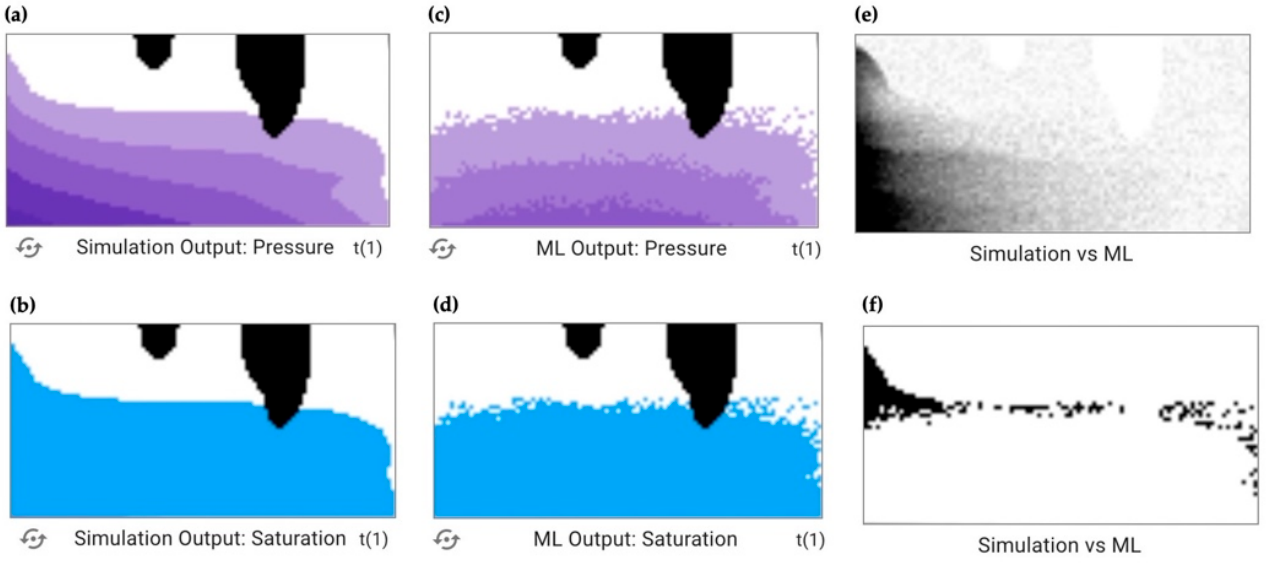
Figure 4. Display of a Sandtank-ML application run, showing ( a ) the “goal” simulation output for pressure, ( b ) the “goal” simulation output for saturation, ( c ) the ML pressure output using a dry dataset, ( d ) the ML saturation output using a dry dataset, ( e ) the difference between the simulation output and the ML output for pressure, and ( f ) the difference between the simulation output and the ML output for saturation.